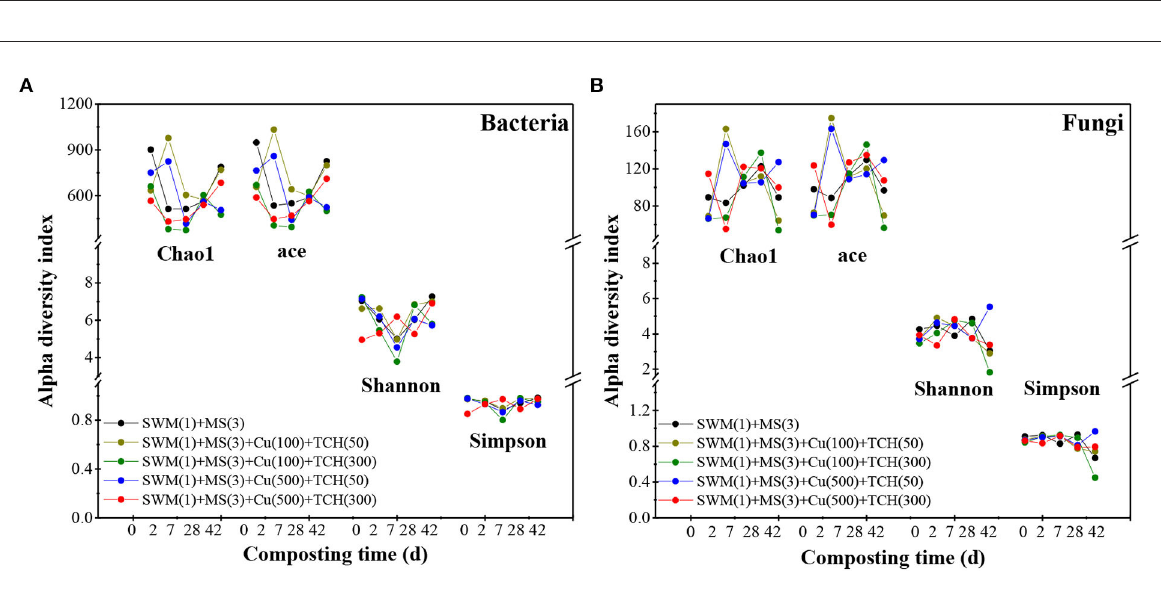
FIGURE4 Alpha -diversity indexes related to bacterial (A) and fungal (B) communities based on OUTs during the composting